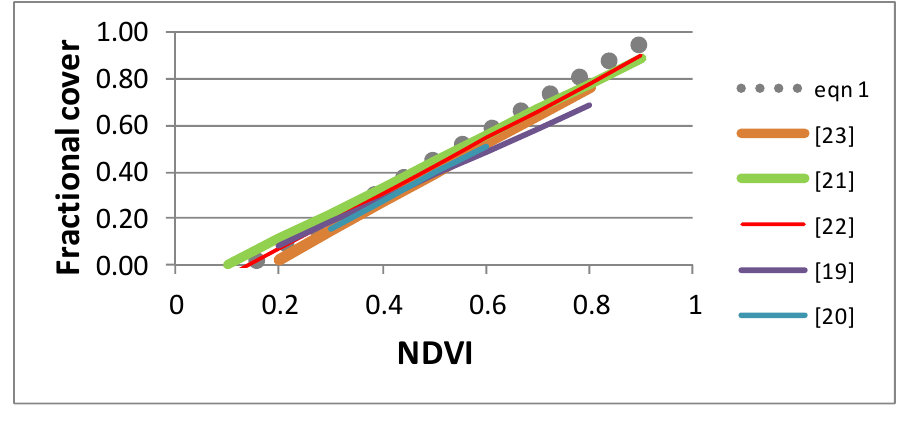
Figure 5. Comparison of Equation (1) with published relationships for multiple horticultural crops [23], wheat [21,22], barley [19], and grape [20]. Each line covers approximate data range of respective